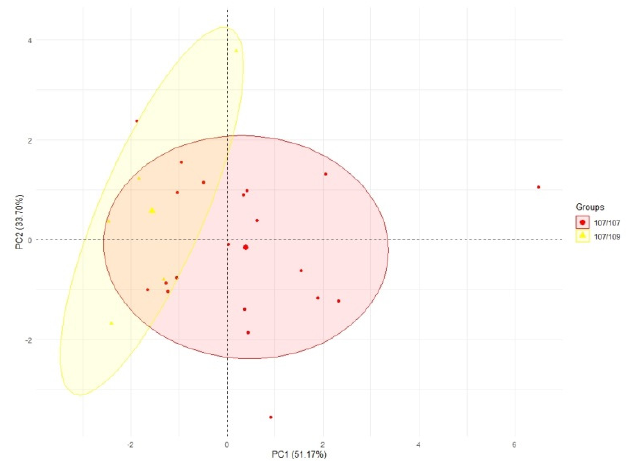
Figure 3. PCA for the S0064 marker in Polish Landrace sows: A scatter plot of PC1 against PC2, with the indication of the genotype. PC1 was positively correlated with the number and the percentage of stillborn piglets per litter, the percentage of live-born piglets and the number of weaned piglets, while PC2 was negatively correlated with the total number of piglets born per litter and the number of live-born piglets per litter. The axes represent loadings onto components 1 and 2, while the two ellipses represent the two genotypes.